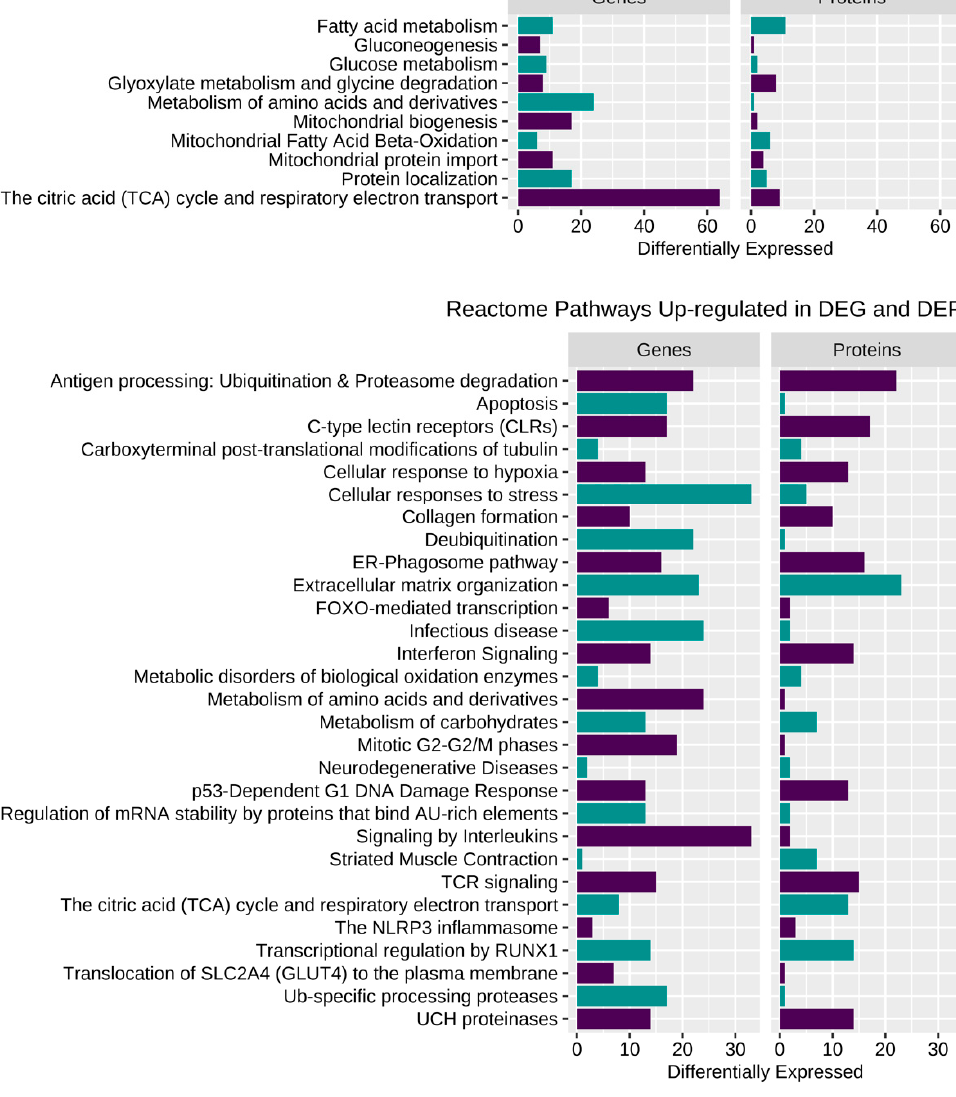
Figure 6. Pathway enrichment for DEG and DEP. ( A ). Enriched Reactome pathways from the amalgamated analysis of B. down-regulated DEP and DEG and ( B ). Up-regulated DEP and DEG.